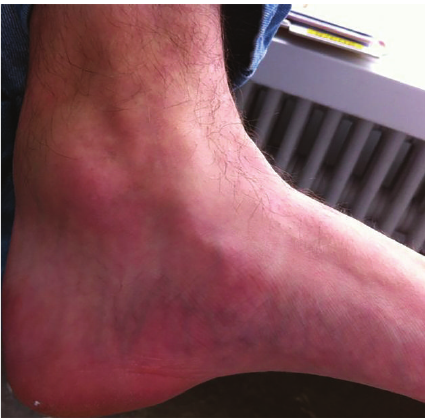
Figure 1: Clinical aspect of the tumorous mass adjacent to the ankle joint.